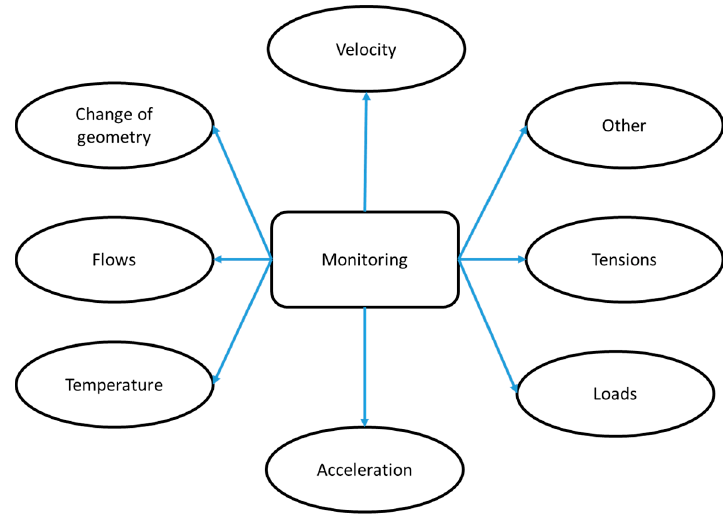
Figure 1. Monitoring technical facilities.